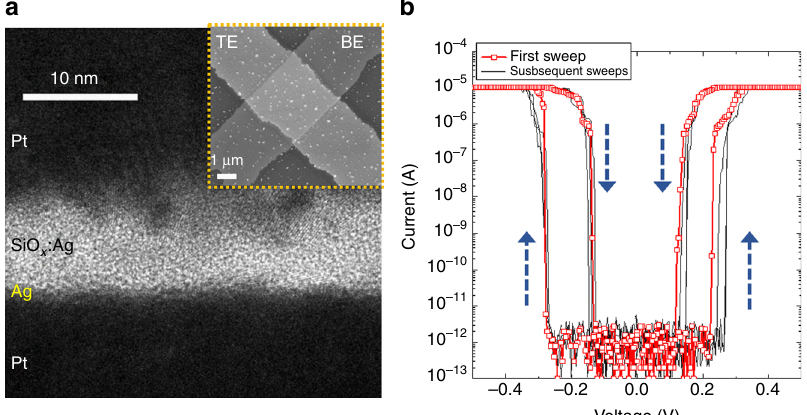
Fig. 2 Memristor structure and electrical behavior. a High resolution cross-sectional TEM image of a diffusive memristor with a stack of Pt/SiO x :Ag/Ag/Pt. Inset shows the top-view SEM image of the cross-bar device with a junction area of 2.5 × 2.5 μ m 2 . b Typical current – voltage ( I – V ) curves for the threshold switching under quasi-DC voltage sweeps. The very fi rst switching events are in red and the subsequent curves are in gray. Blue arrows indicate the switching Figure 2b shows typical I – V curves of the bi-directional threshold switching behavior of the Pt/SiO x :Ag/Ag/Pt device under voltage sweeps (0 to 0.5 V or − 0.5 V). A compliance current ( I cc ) of 10 μ A was adopted during the measurements to avoid damage to the device. As the voltage increased to around 0.25 V (or − 0.25 V), the device was turned on and the current rapidly reached the I cc level. After removal of the voltage sweep, the device turned itself off spontaneously from its on-state with a sudden current drop at around 0.15 V (or − 0.15 V). The response of the device to the quasi-DC voltage sweeps represents the typical threshold switching behavior as previously reported 55,56 .